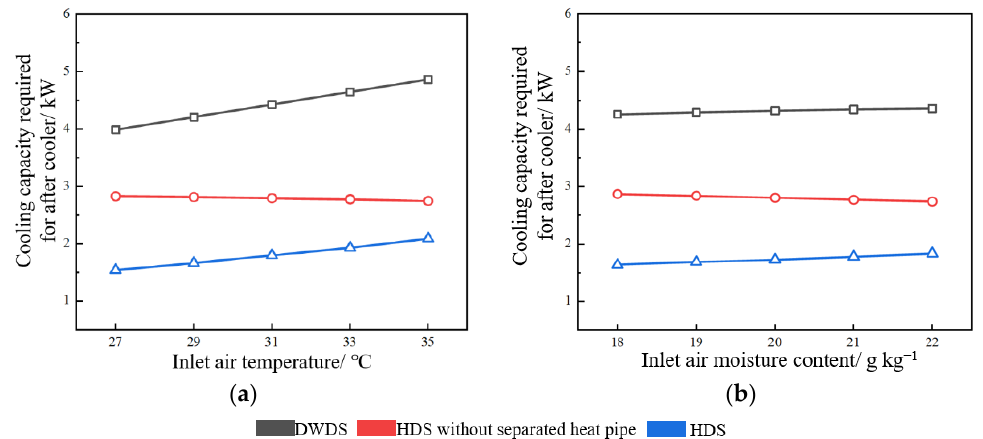
Figure 9. Cooling capacity required for the aftercooler of three dehumidification systems. ( a ) Inlet air temperature. ( b ) Inlet air moisture content.